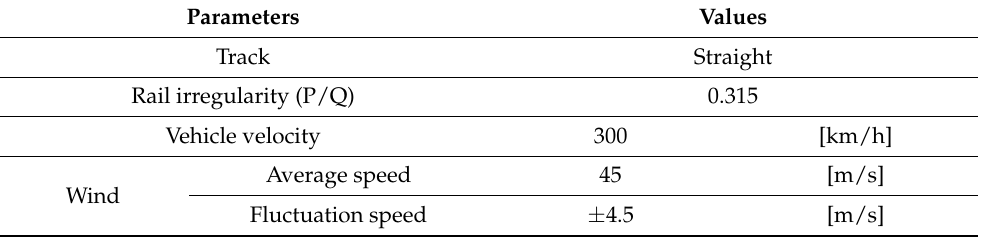
Table 12. The conditions to compare the derailment coefficients according to cross-wind frequencies. Parameters Values Track Straight Rail irregularity (P/Q) 0.315 Vehicle velocity 300 [km/h] Average speed 45 [m/s] Wind Fluctuation speed ± 4.5